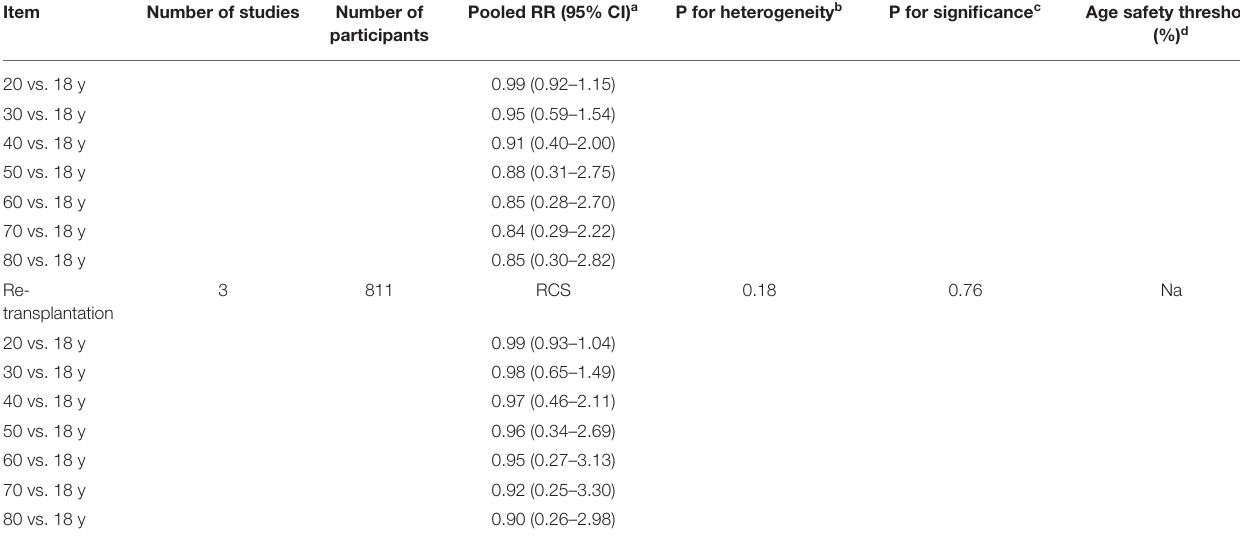
as short-term post-transplant complications (both P > 0.05), but might amplify the effects of graft age on GF (all P < 0.05); and